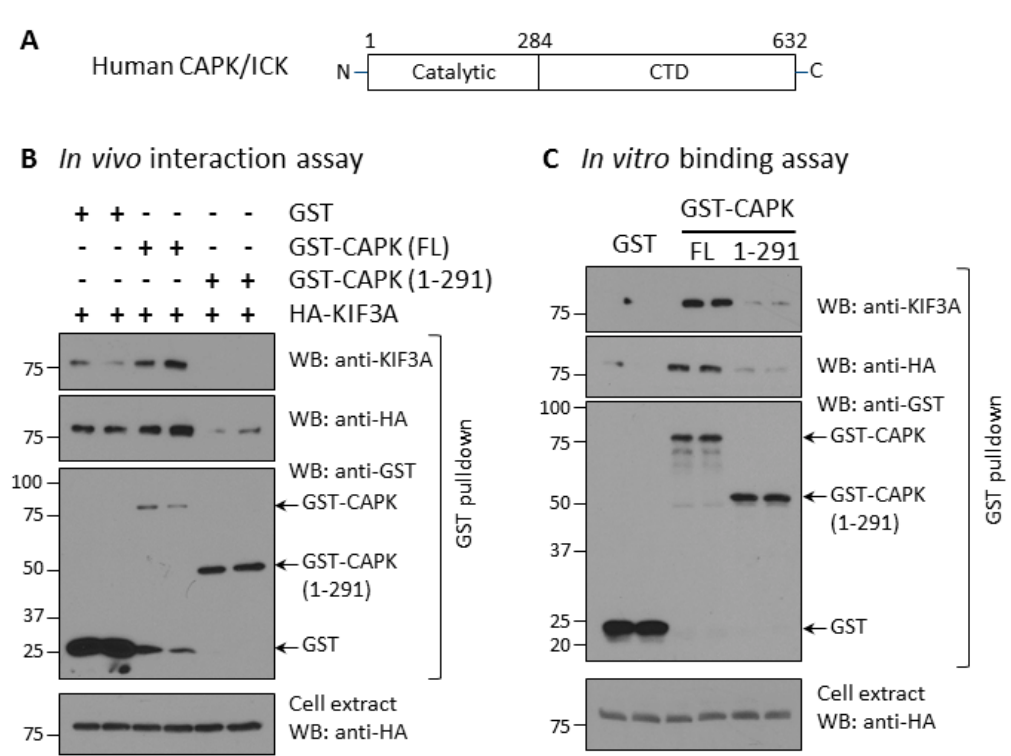
Figure 2. The C-terminal domain (CTD) of CAPK is required for its physical interaction with KIF3A. ( A ) Human CAPK has two basic structural domains: the N-terminal catalytic domain (4–284 aa) and the non-catalytic C-terminal domain (285–632 aa). ( B ) The CTD is required for CAPK interaction with KIF3A in vivo. GST, GST-CAPK full-length (FL), or CTD-truncated (1–291) were co-expressed with HA-KIF3A in HEK293T cells. After GST pull-down, HA-KIF3A bound to GST glutathione beads or in cell extracts were detected by Western blotting against HA or KIF3A antibodies. ( C ) The CTD is required for binding of CAPK to KIF3A in vitro. GST, GST-CAPK FL, or CTD-truncated (1–291) were expressed in HEK293T cells, affinity-purified, and captured on glutathione Sepharose beads. GST beads were then incubated with cell extracts containing HA-KIF3A. HA-KIF3A proteins bound to GST glutathione beads were assessed by Western blotting against HA or KIF3A antibodies.